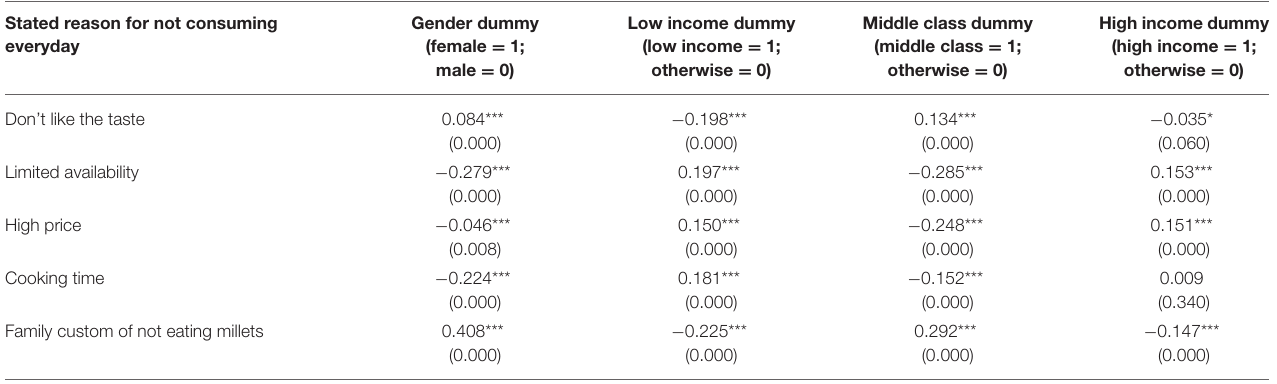
TABLE 5 | Tetrachoric correlation between respondents’ reasons for not consuming millets/sorghum and their demographic profile. Stated reason for not consuming everyday